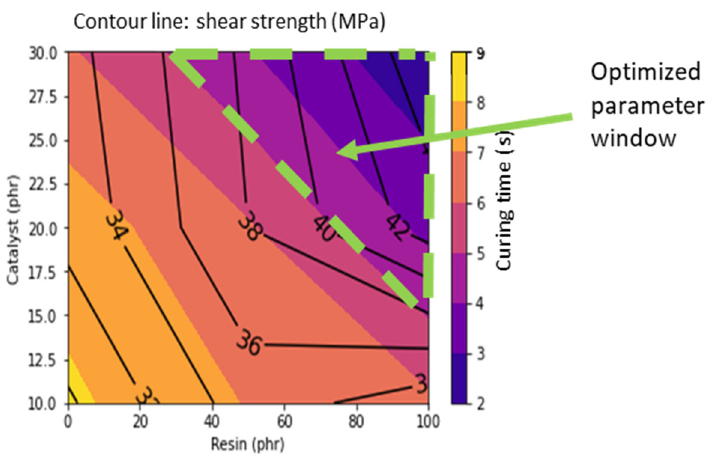
Figure 8. The optimized NCA formulation. Curing time (s) is contoured by color, and shear strength (MPa) is contoured by